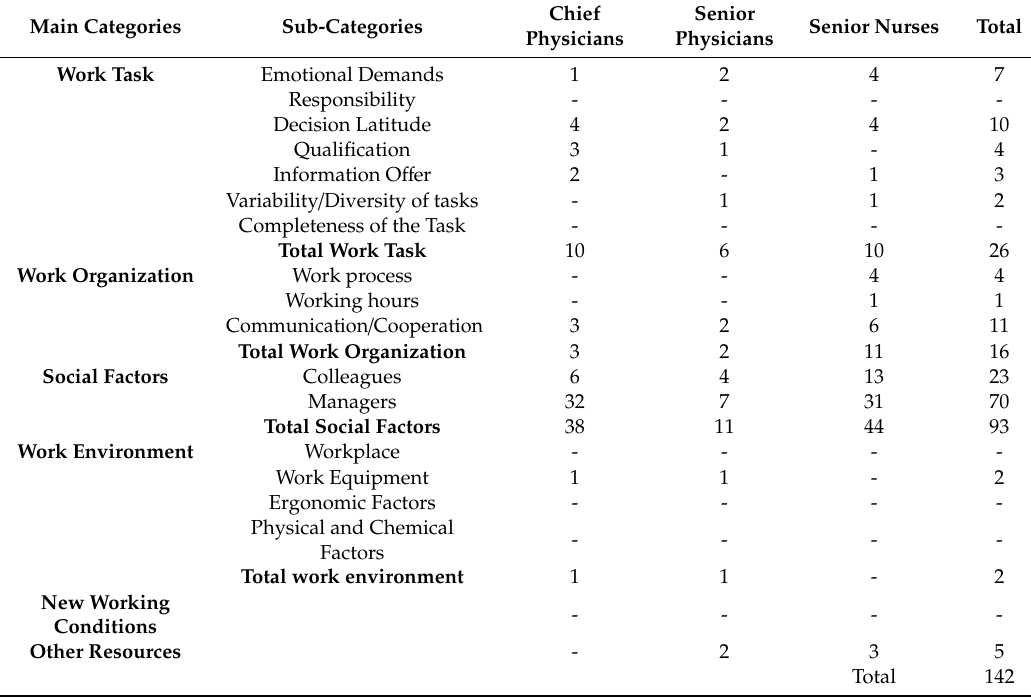
Table A3. Number of mentioned resources per manager und